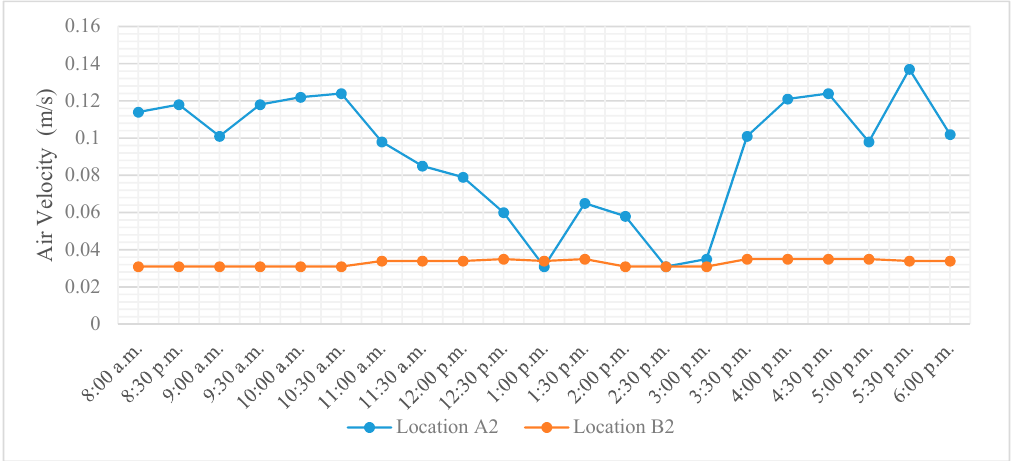
Figure 18. Indoor air velocity in the room of Building A (Location A2) and Building B (Location B2).